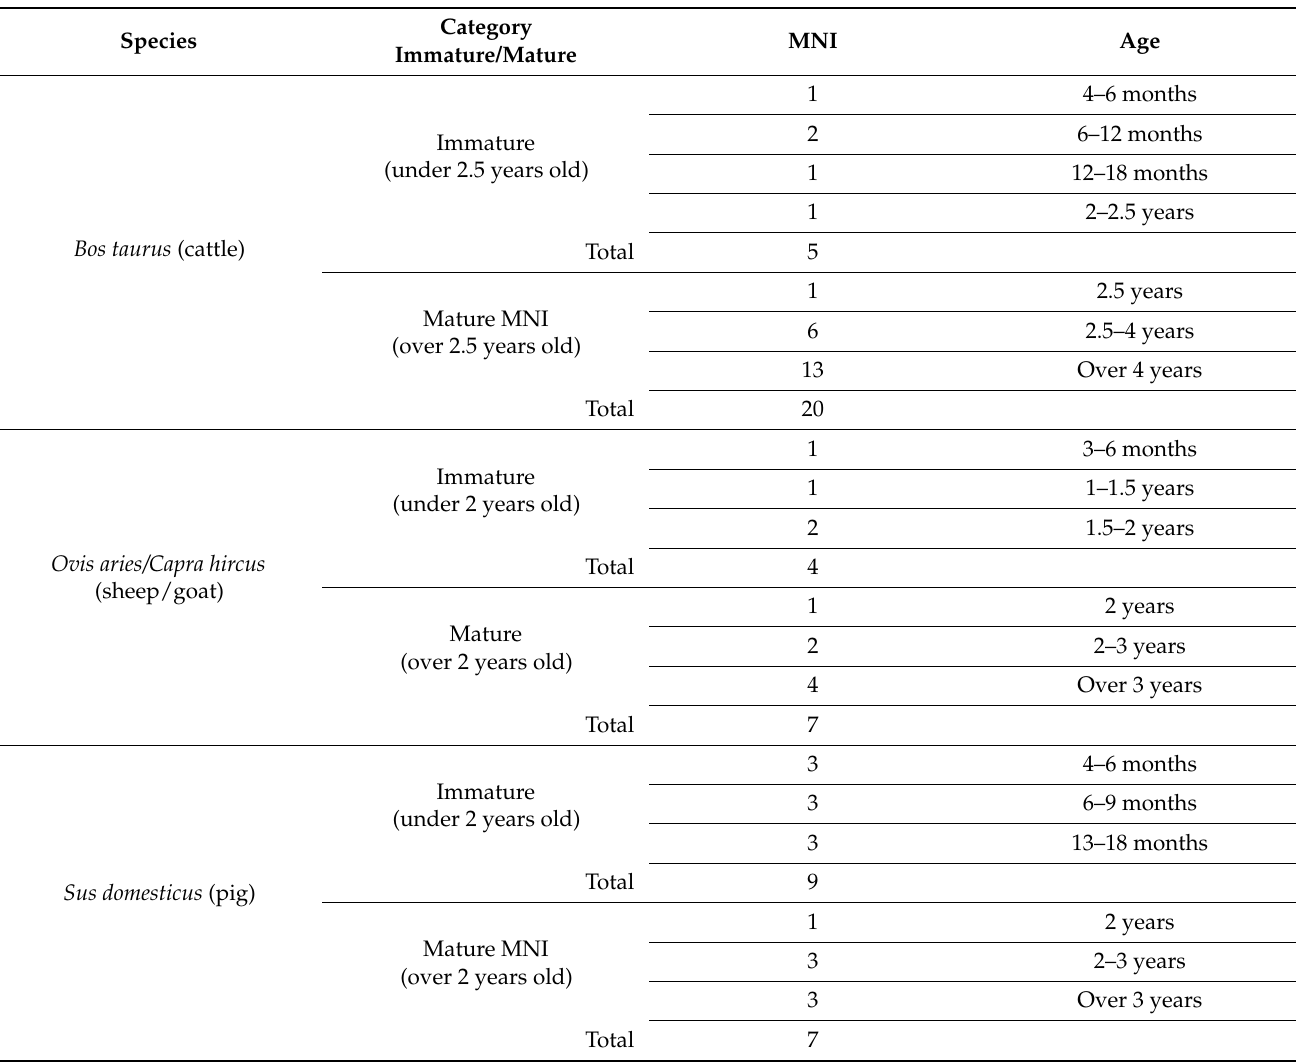
Figure 11. Halmyris, Romania, 2014, extramuros area (4th–6th centuries AD). Proportions between immature and mature estimated individuals of Bos taurus (cattle), Ovis aries/Capra hircus (sheep/goat), and Sus domesticus (pig) in extramuros sample. Table 5. Halmyris, Romania, 2014, extramuros area (4th–6th centuries AD). Dental age of slaughter for estimated individuals of Bos taurus , Ovis aries/Capra hircus , and Sus domesticus in extramuros sample (MNI—minimal number of individuals).